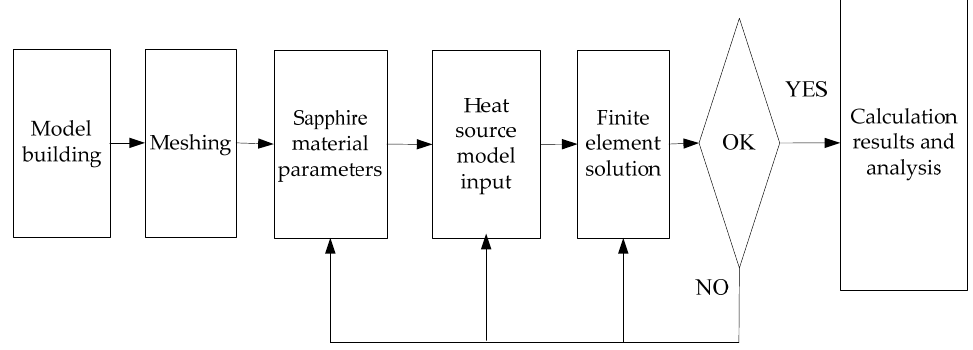
Figure 4. The temperature simulation flow diagram.